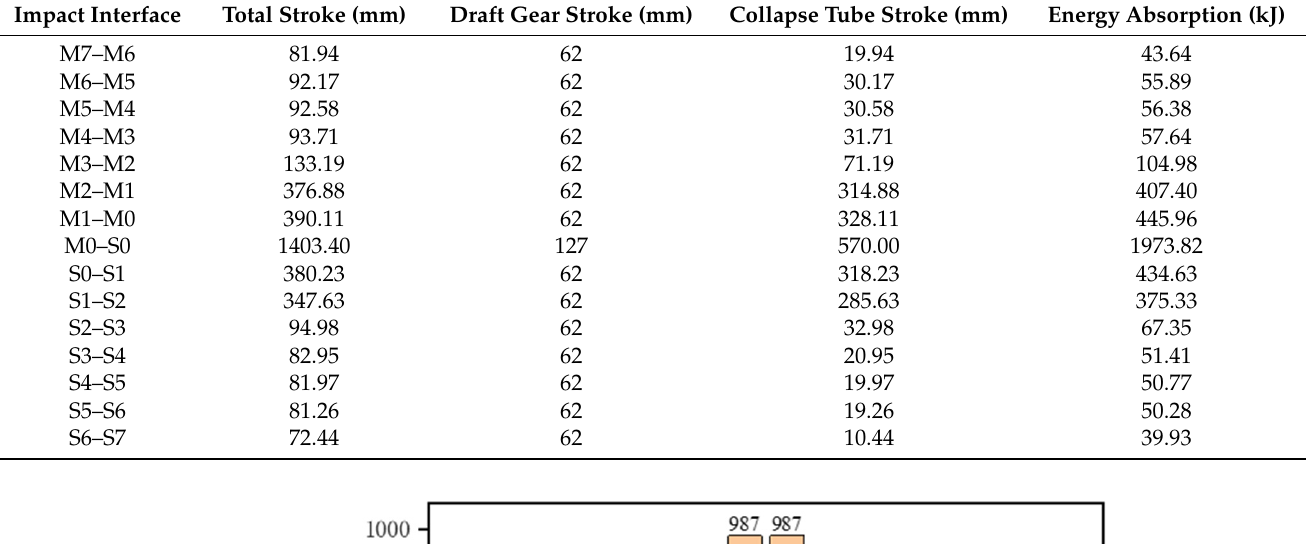
Table 2. Simulation results.